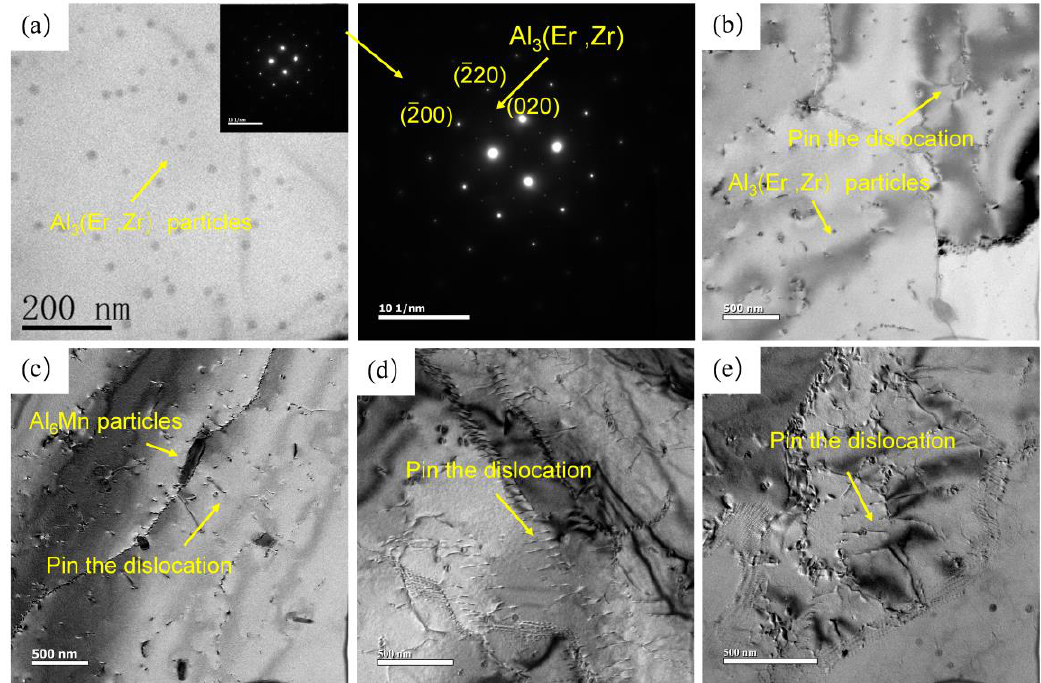
Figure 6. Characteristics of Al 3 (Er, Zr) precipitates in alloys under different deformation conditions: ( a ) homogenization state; ( b ) 450 °C/0.01 s − 1 ; ( c ) 450 °C/0.1 s − 1 ; ( d ) 450 °C/1 s − 1 ; ( e ) 450 °C/10 s − 1 . Table 2. Hot deformation activation energy of several alloys. Composition of Alloy Value of Hot Deformation Activation